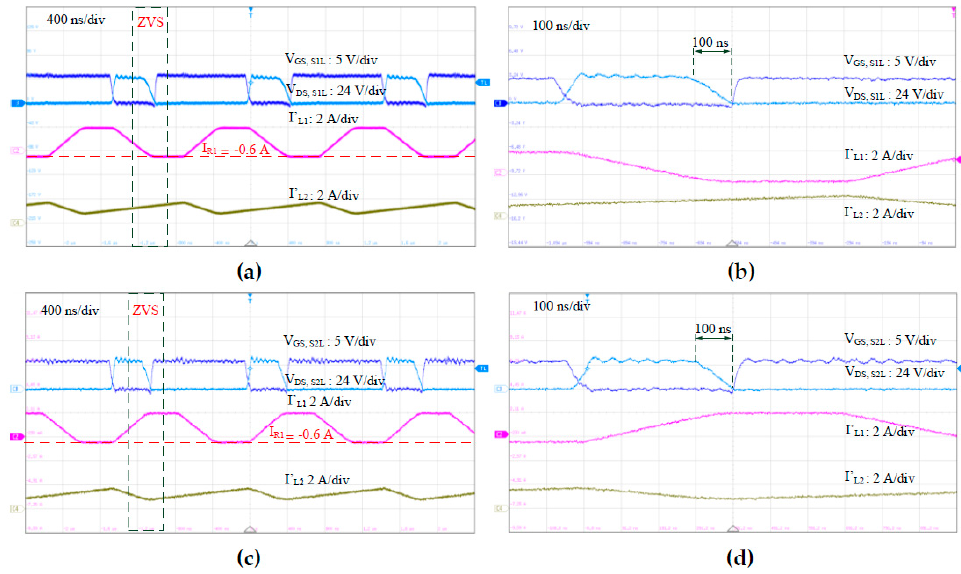
Figure 13. Experimental waveforms at 20% load in the reverse direction: ( a ) resonant period of S 1L ; ( b ) detailed ZVS of S 1L ; ( c ) resonant period of S 2L ; ( d ) detailed ZVS of S 2L .